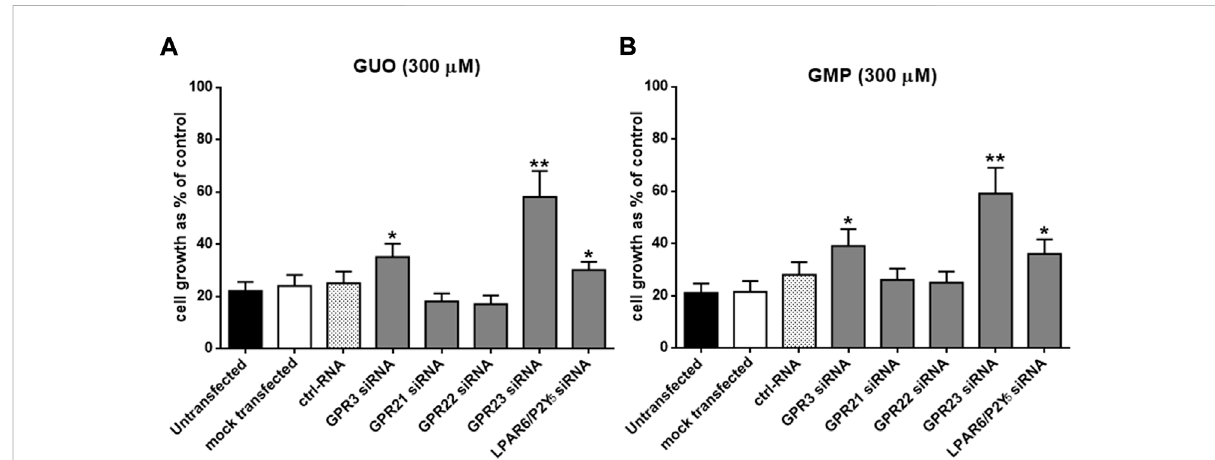
FIGURE 1 Effects of lipotransfection with different GPCR-siRNAs on sensitivity to GUO (A) and GMP (B) . U87 cells, grown up to 50% con fl uency into 96multiwell plates, werelipotransfected in theabsence ofsiRNAs (mock transfected),inthe presence of 50 nM ctrlRNA or inthepresence of50 nM GPR3-siRNA, GPR21-siRNA, GPR22-siRNA, LPAR6/P2Y 5 -siRNA and GPR23-siRNA and then incubated in growth medium. After 24 h cells were treatedwithGUOorGMP(300 μ M)for72 h.CellgrowthwasevaluatedbytheMTTassay.Resultsareexpressedasthepercentageofcellgrowth evaluated in untreated cells (control). Each point represents the mean ± SD of 3 independent experiments. Statistical signi fi cance: * p < 0.05 ** p < 0.01 vs. mock transfected cells (Student ’ s t test).